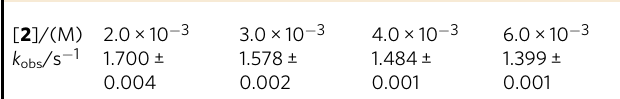
Table 1 The observed rate constants ( k obs , s − 1 ) with different concentrations of